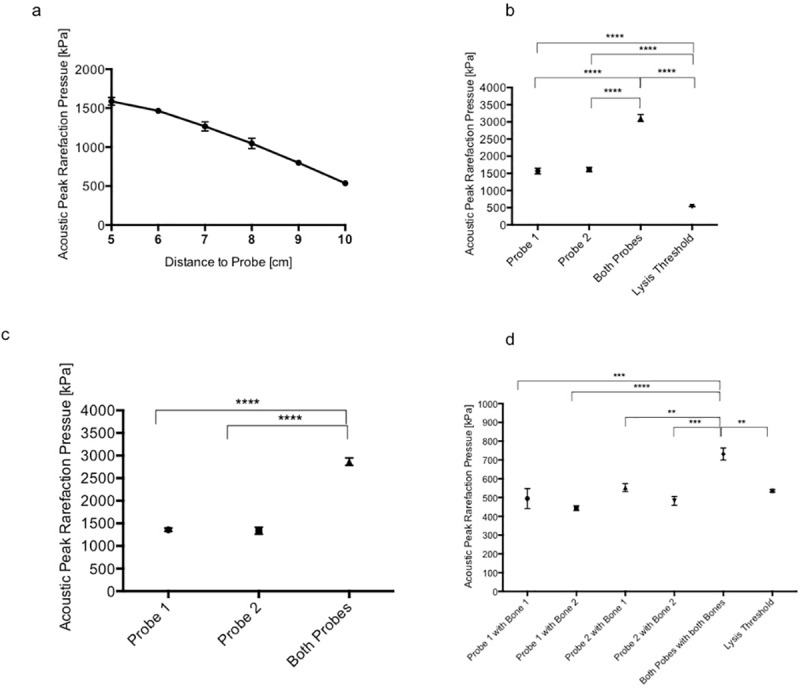
Acoustic Peak Rarefaction Pressure (APRP) measurement.(a) APRP values (y-axis) of 2 MHz Doppler are measured in different distances to probe (x-axis) (mean, SE) (n = 3). At the outer edge of lysis radius (10 cm) 535.5±7.2 kPa was measured (lysis threshold). (b) Acoustic Peak Rarefaction Pressure (APRP) measurement (n = 3) using one or two Doppler Probes in a water bath. Means and SE of APRP measurements are shown using Doppler probe 1 or 2 or both of them. These measurements were related to lysis threshold, **** p<0.0001. (c) Acoustic Peak Rarefaction Pressure (APRP) measurement (n = 3) using one or two Doppler Probes in an agar brain model. Means and SE of APRP measurements are shown using Doppler probe 1 or 2 or both of them,**** p<0.0001. These values were similar to the measurements in the water bath. (d) Acoustic Peak Rarefaction Pressure (APRP) measurement (n = 3) using one or two Doppler probes considering bone attenuation. Means and SE of APRP measurements are shown using ultrasound probe 1 and probe 2 attenuated by a temporal bone 1 and 2. All combinations were performed and compared to the use of both probes and bones placed vis-à-vis (cranial setting) and to lysis threshold. ****p<0.0001, probe1+bone1 versus both probes+both bones: ***p = 0.0007, probe2+bone2 versus both probes+both bones:***p = 0.0004, probe2+bone1 versus both probes+both bones: **p = 0.0091, both probes+both bones versus lysis threshold:**p = 0.0043.